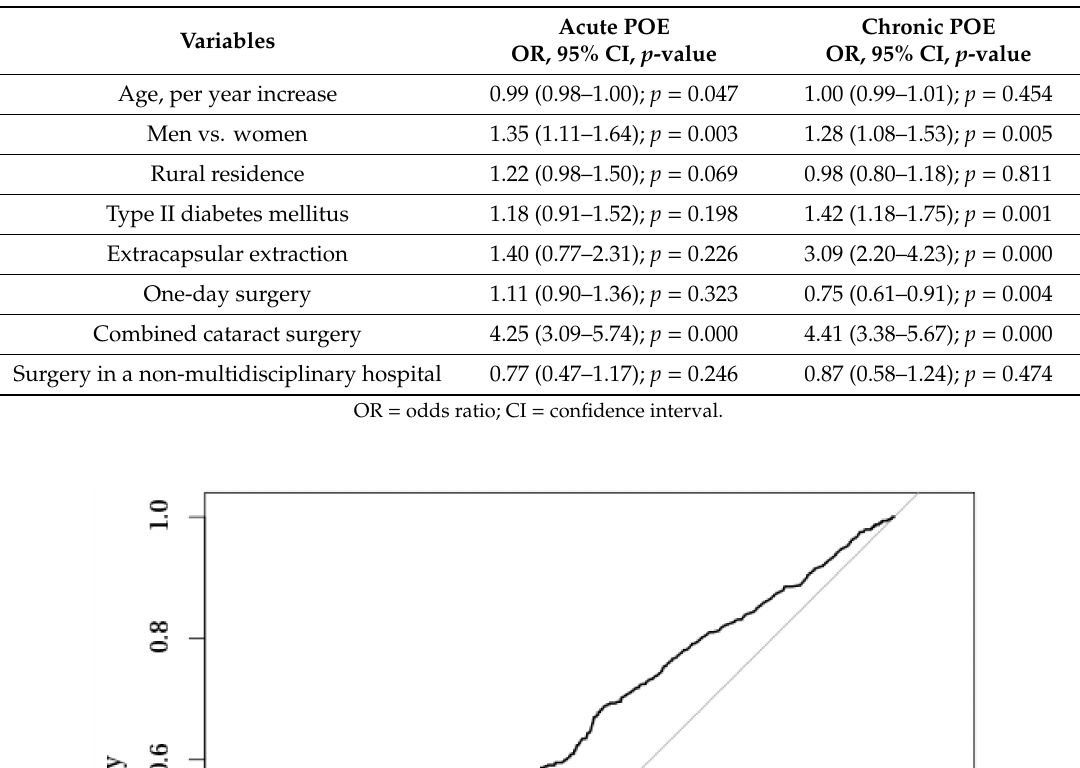
Table 5. Multiple logistic regression models of the risk factors for acute and chronic postoperative endophthalmitis (POE).